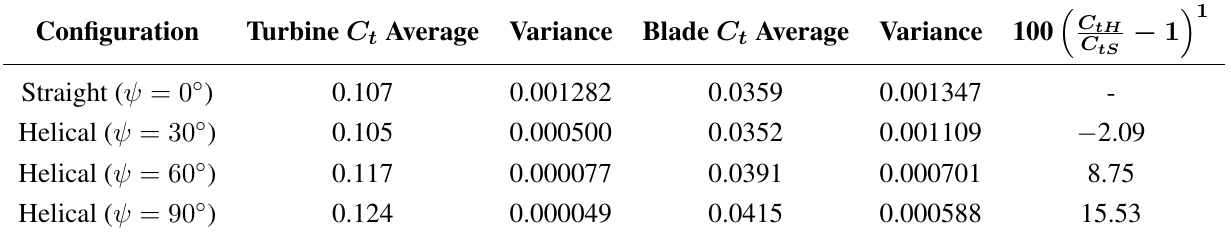
Table 4. Comparison of the average torque coefficient between ψ = 0 ◦ , 30 ◦ , 60 ◦ , 90 ◦